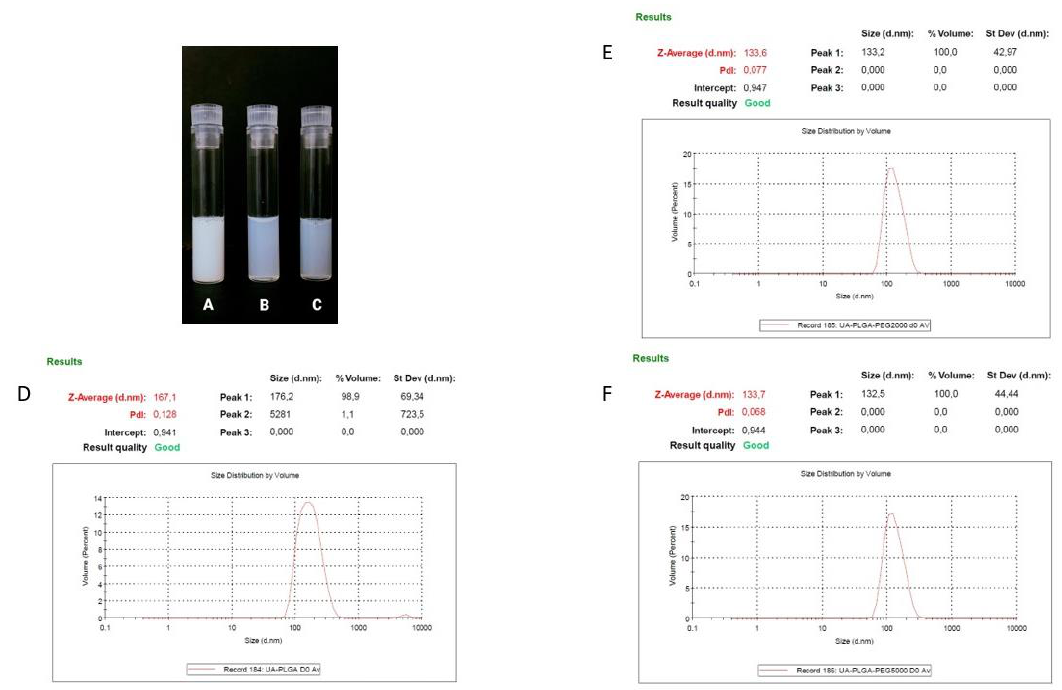
Figure 1. Visual appearance of the UA encapsulated nanoparticles and DLS averaged measurements results ( n = 3) for each of the UA nanoparticles, with size [nm] and PDI values shown. ( A , D ). UA-PLGA, ( B , E ). UA-PLGA-PEG 2000, ( C , F ) UA-PLGA-PEG 5000.